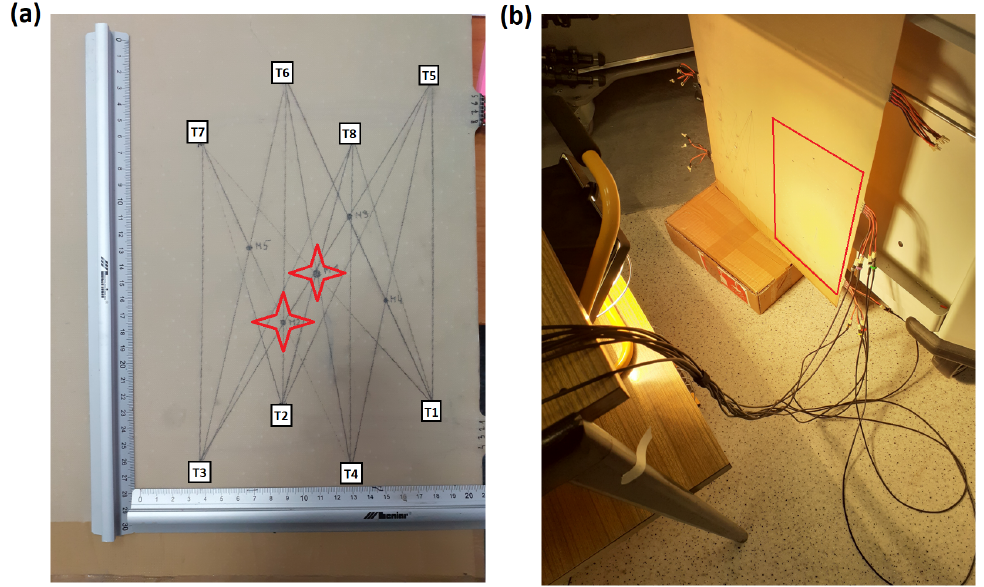
Figure 4. View of specimen no. 2: ( a ) PZT sensors network geometry with an indication of introduced impact damage location; ( b ) specimen heated with the use of halogen lamps with an indication of the monitored